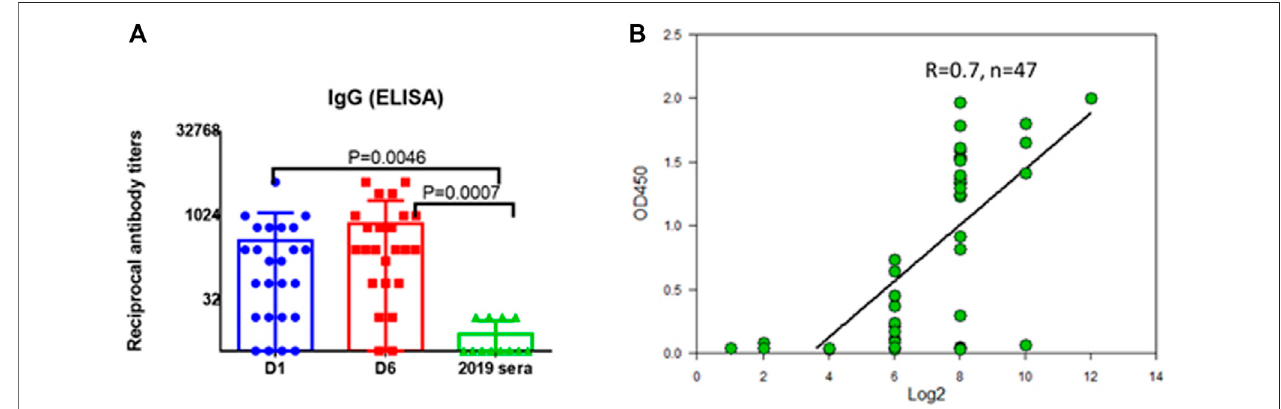
FIGURE2| SerumIgGtorecombinantSarsS-proteininpatients withcon fi rmedSARS-CoV-2infection. (A) D1 — fi rstdayofhospitalstay(n (cid:1) 28), D6 — sixthdayof hospital stay (n (cid:1) 28), 2019 sera were obtained from the patients examined in 2019 (n (cid:1) 14). (B) 47 serum samples from patients with con fi rmed SARS-CoV-2 infection werestudied using acommercial kit fordetecting IgGantibodies tocoronavirus “ SARS-Cov-2 IgG Screen ” (Imbian, Russia) in comparison withrecombinantS1 protein. Ahighlevelofcorrelationwasshown(Spearman ’ srankcorrelationcoef fi cient (cid:1) 0.7,n (cid:1) 47)whendetectingserumantibodiestoSARS-CoV-2usingarecombinant protein and using a commercial kit. A high level ofcorrelationwas shown when serum IgG were detected using “ SARS-Cov-2IgG Screen ” kit or recombinant S-protein, Spearmen r (cid:1) 0.7. The positive value according to the screen data corresponded to 1:256 antibody titers obtained using S-protein.